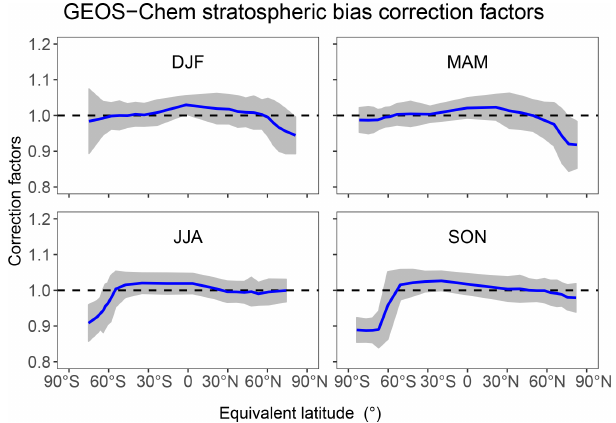
Figure 2. GEOS-Chem stratospheric bias correction based on ACE- FTS observations. The figure shows the ACE-FTS to GEOS-Chem ratio of stratospheric methane sub-columns as a function of equiva- lent latitude and season, averaged over the 2010–2015 period. Grey shading represents the fitting